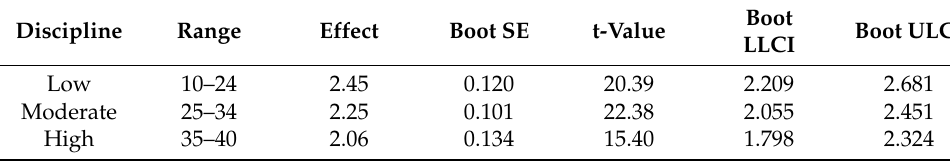
Table 6. Conditional focal predictor at values of the